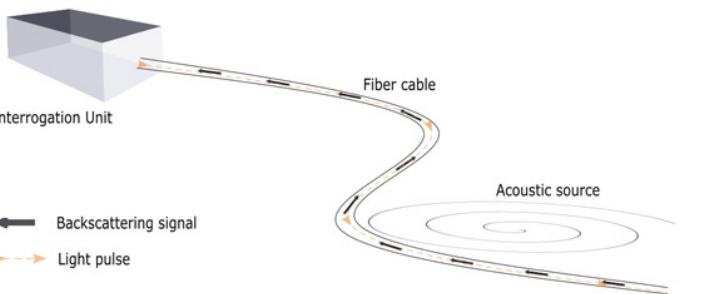
Figure 2. The DAS IU receiving light pulse traveling back (backscattered signal) inside the fiber cable recording acoustic signatures along the way. Source: